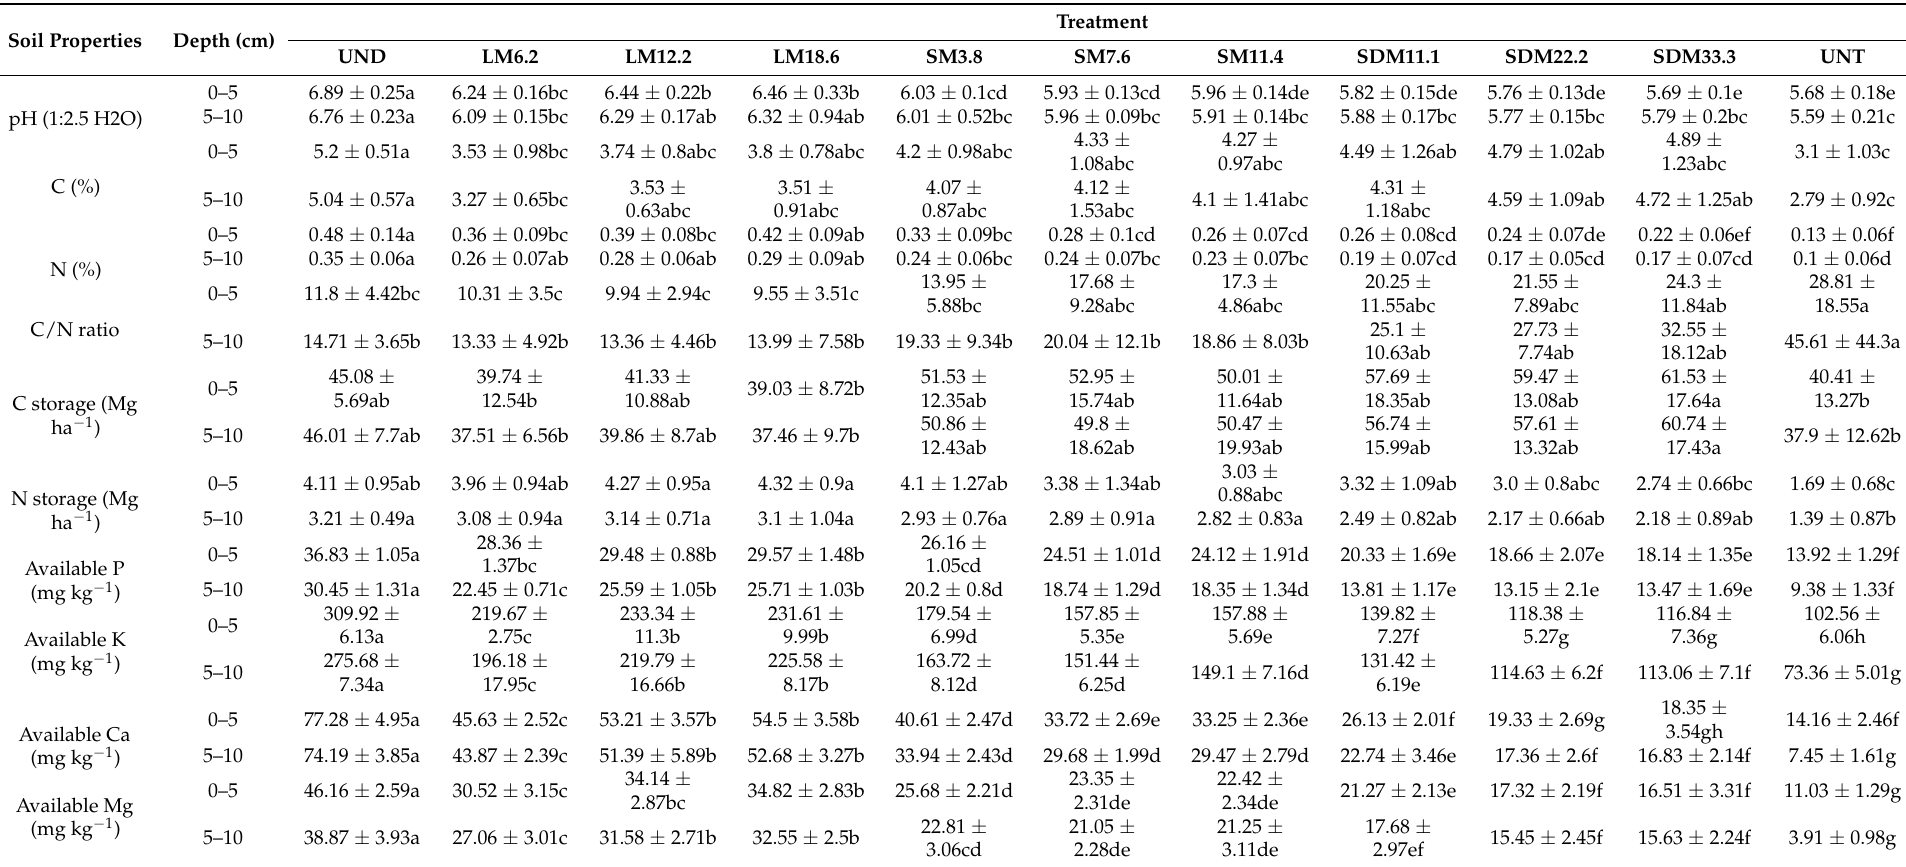
Table 3. Mean values ( ± SD) of different soil chemical properties in different treatments. UND, undisturbed (control); LM6.2, litter mulch level of 6.2 Mg ha − 1 ; LM12.2, litter mulch level of 12.2 Mg ha − 1 ; LM18.6, litter mulch level of 18.6 Mg ha − 1 ; SM3.8, straw mulch level of 3.8 Mg ha − 1 ; SM7.6, straw mulch level of 7.6 Mg ha − 1 ; SM11.4, straw mulch level of 11.4 Mg ha − 1